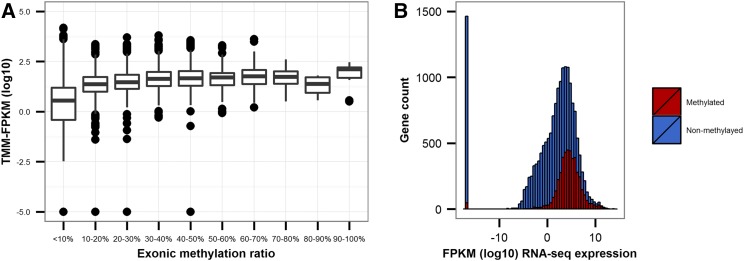
The relationship between methylation and gene expression in H. armigera. (A) Distribution of RNA sequencing (RNA-seq) TMM (Trimmed mean of M-values)-fragments per kilobase of exon per million fragments mapped (TMM-FPKM log10) expression stratified by exon methylation bins (10%). (B) Density plots for expression data for individual genes per methylated (red) or nonmethylated (blue) status, based on ± 10% exonic methylation.